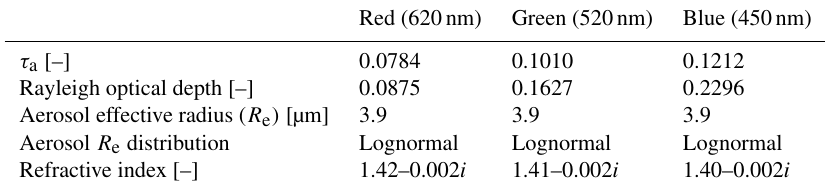
Table 1. Atmospheric radiative properties for the ARM site used as input to SHDOM. τ a and Rayleigh optical depth are averages for the year 2013 from AERONET